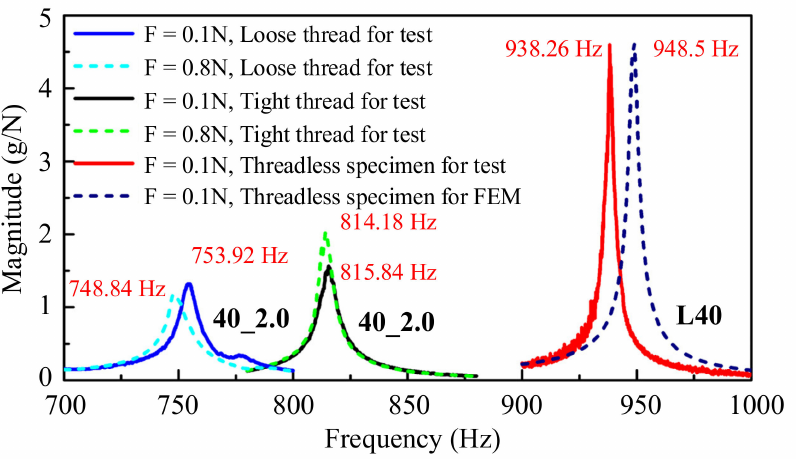
Figure 4. FRF curves of the threadless specimen (L40) and threaded specimen (40_2.0) (source elaborated by